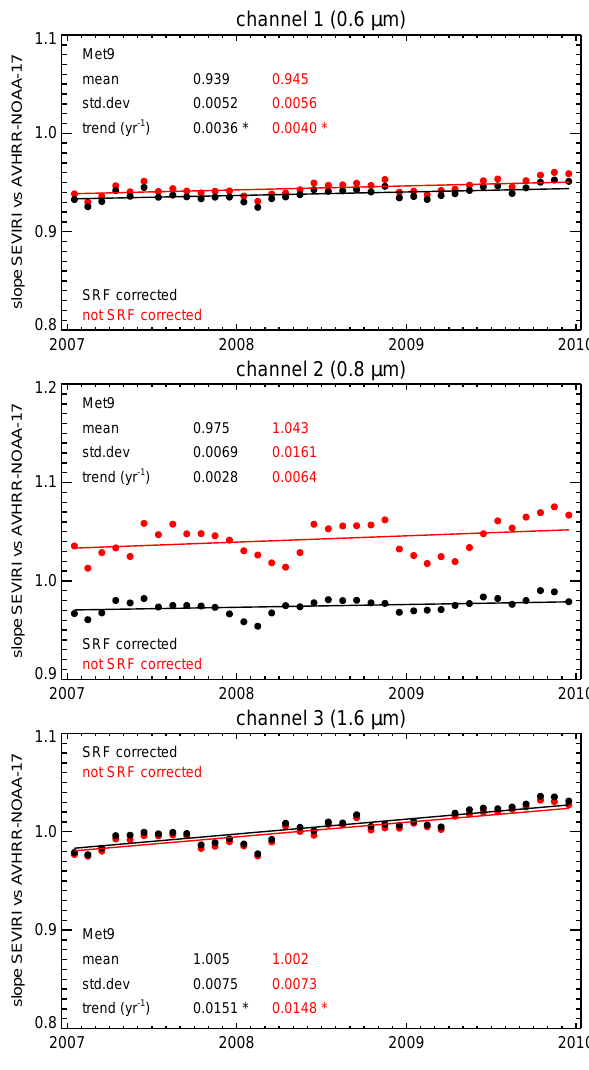
Fig. 6. Same as Fig. 5, but for AVHRR-NOAA17 instead of MODIS-Aqua, and for Meteosat-9